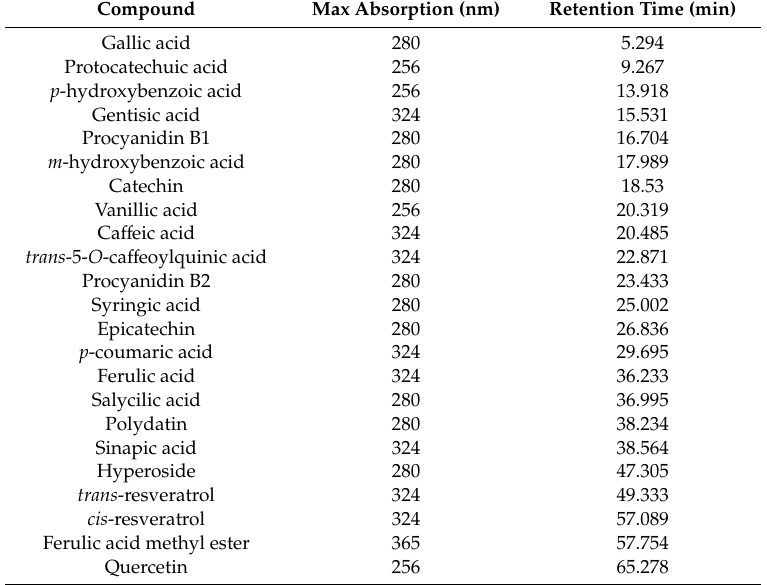
Table 5. Polyphenols used as standards in HPLC analysis and their retention times.